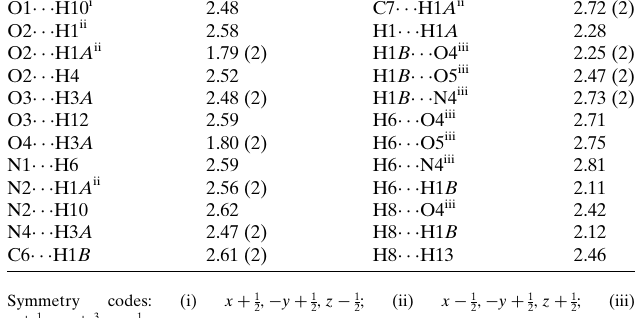
Table 2 Selected interatomic distances (A˚